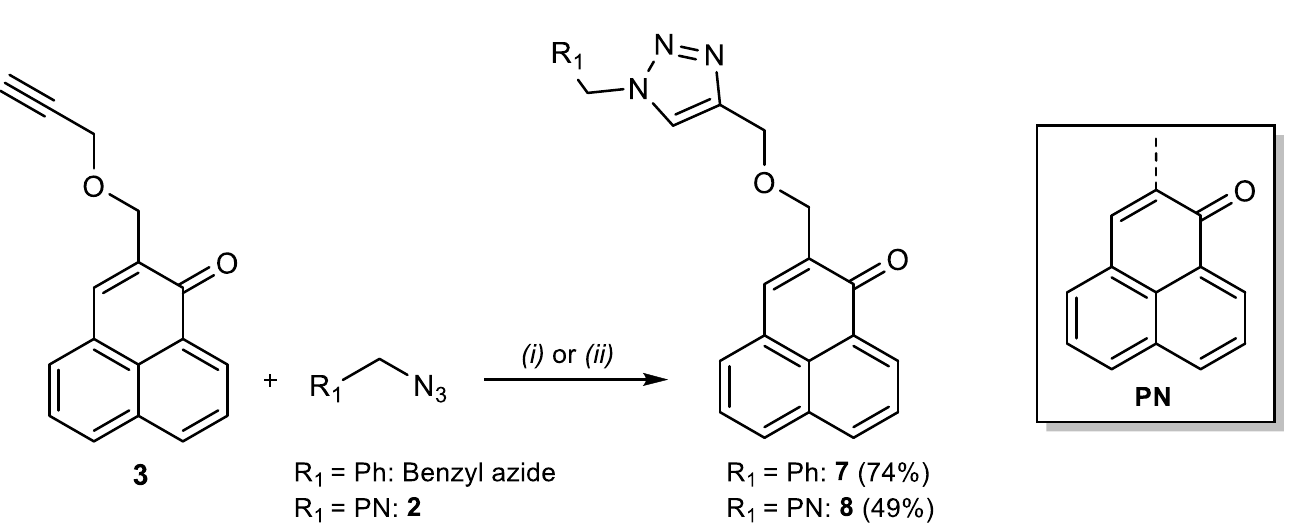
Scheme 1. Synthesis of compounds 7 and 8 from propargyl precursor 3 by CuAAC. Reaction conditions: (i) Benzyle azide (2 eq.), CuI (0.02 eq.), diisopropylethylamine (0.04 eq.), acetic acid (0.02 eq.), 55 h, r.t. (ii) 2 (1 eq.), and CuSO 4 .5H 2 O (0.2 eq.) in tBuOH/H 2 O 1:1, 72 h, r.t.